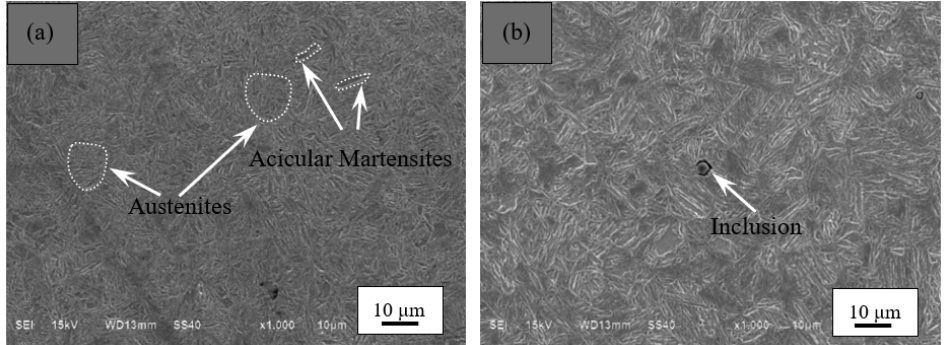
Figure 2. Microstructure of carburized Cr-Ni gear steel: ( a ) microstructure in carburized layer, ( b ) microstructure in matrix and inclusion.